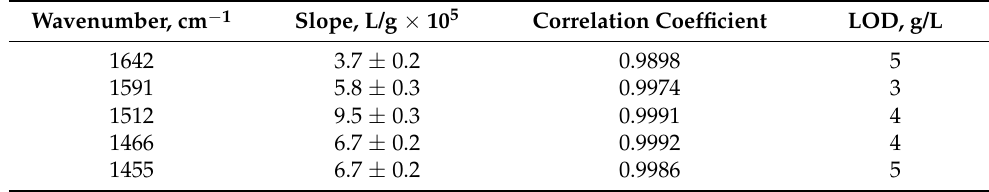
Table 3. Parameters for the quantification of sodium lignosulfonate ( n = 6, p = 0.95). Wavenumber, cm − 1 Slope, L/g × 10